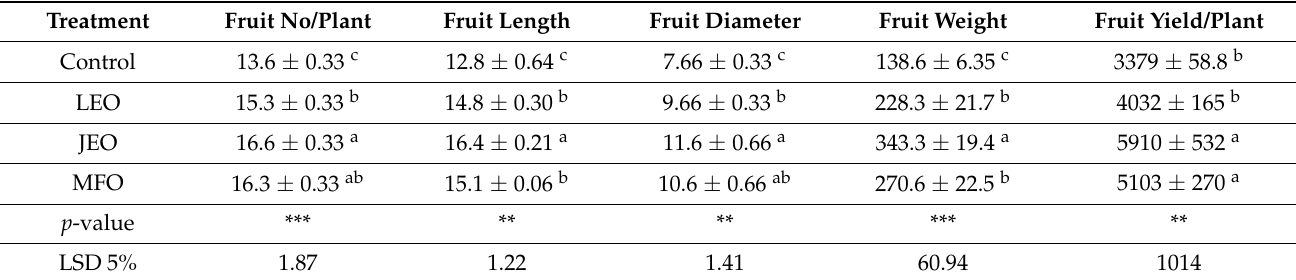
Table 5. The effect of foliar application with jasmine and lavender essential oils or mustard fixed oil on yield and its components of eggplant growth under TSSM natural infestation in a controlled greenhouse.